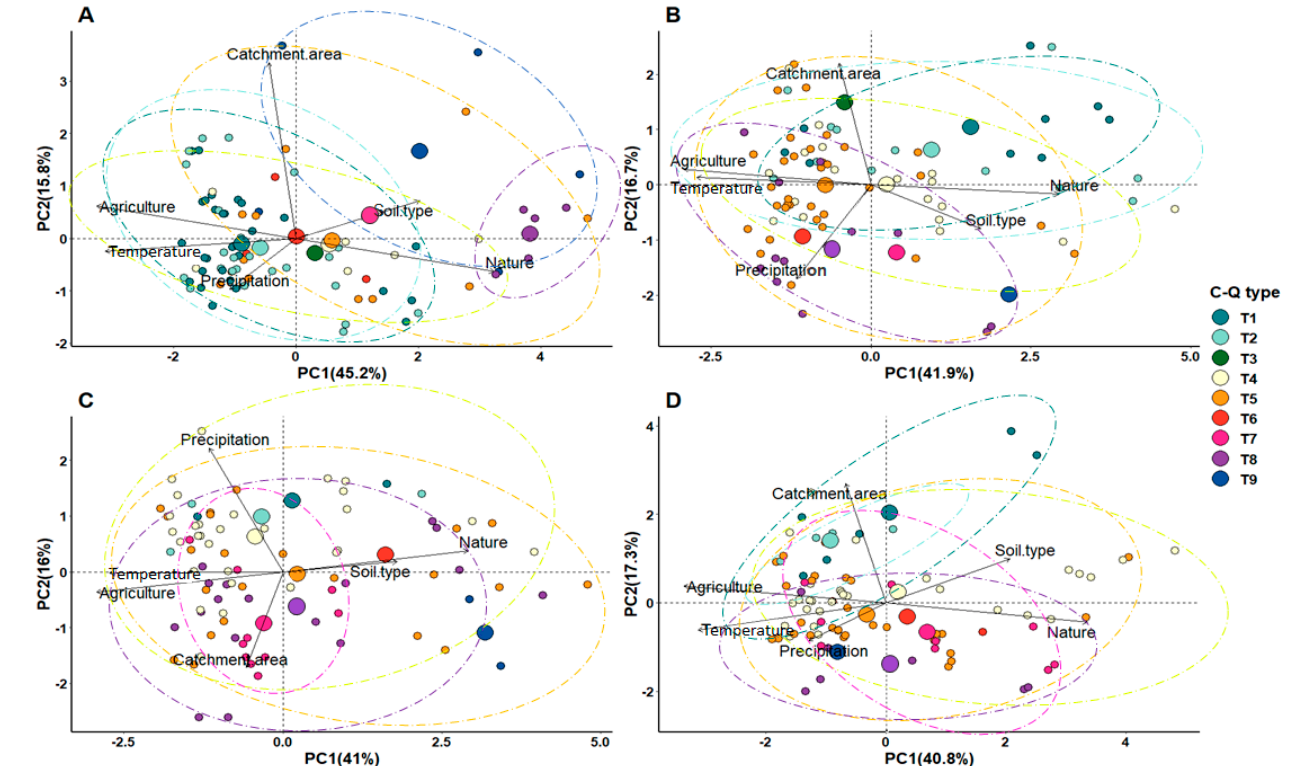
Figure 4. Principal Component Analysis (PCA)—Biplot for C-Q relationship types (T1-T9) of mini-catchments in Denmark, Sweden, and Finland for nitrate (NO 3– ) ( A ), total organic N (TON) ( B ), dissolved reactive P (DRP) ( C ), and particulate P (PP) ( D ). Variables are C-Q relationship types and catchment characteristics: land use (agriculture and nature), climate (mean daily precipitation and air temperature), soil type, and catchment area (km 2 ). PC 1 and 2 are the percentages of variance explained by principal component 1 and 2, respectively. Large individual points represent the centroid of the nine C-Q relationship types. Ellipses are drawn around the clusters.